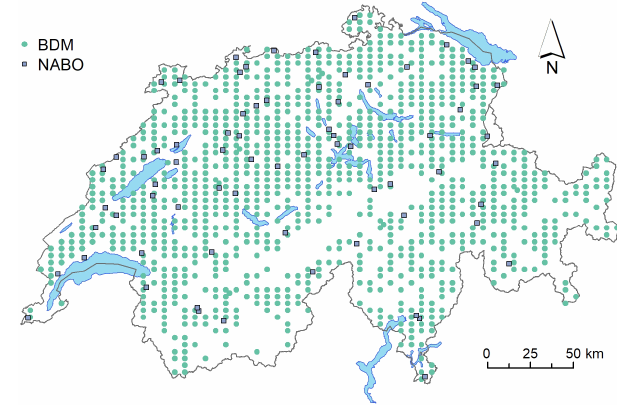
Figure 1. Map of Switzerland with sampling locations of the mid- IR spectral library, including the sites of the Biodiversity Moni- toring program (BDM; 6 × 4km; n = 1094) and the National Soil Monitoring Network (NABO; n = 71). In total, 71 NABO sites (10m × 10m) were sampled with a grid-based stratified design, and 1094 BDM samples were obtained from single sampling events. The NABO sites have been continuously sampled and measured in 5-year intervals since